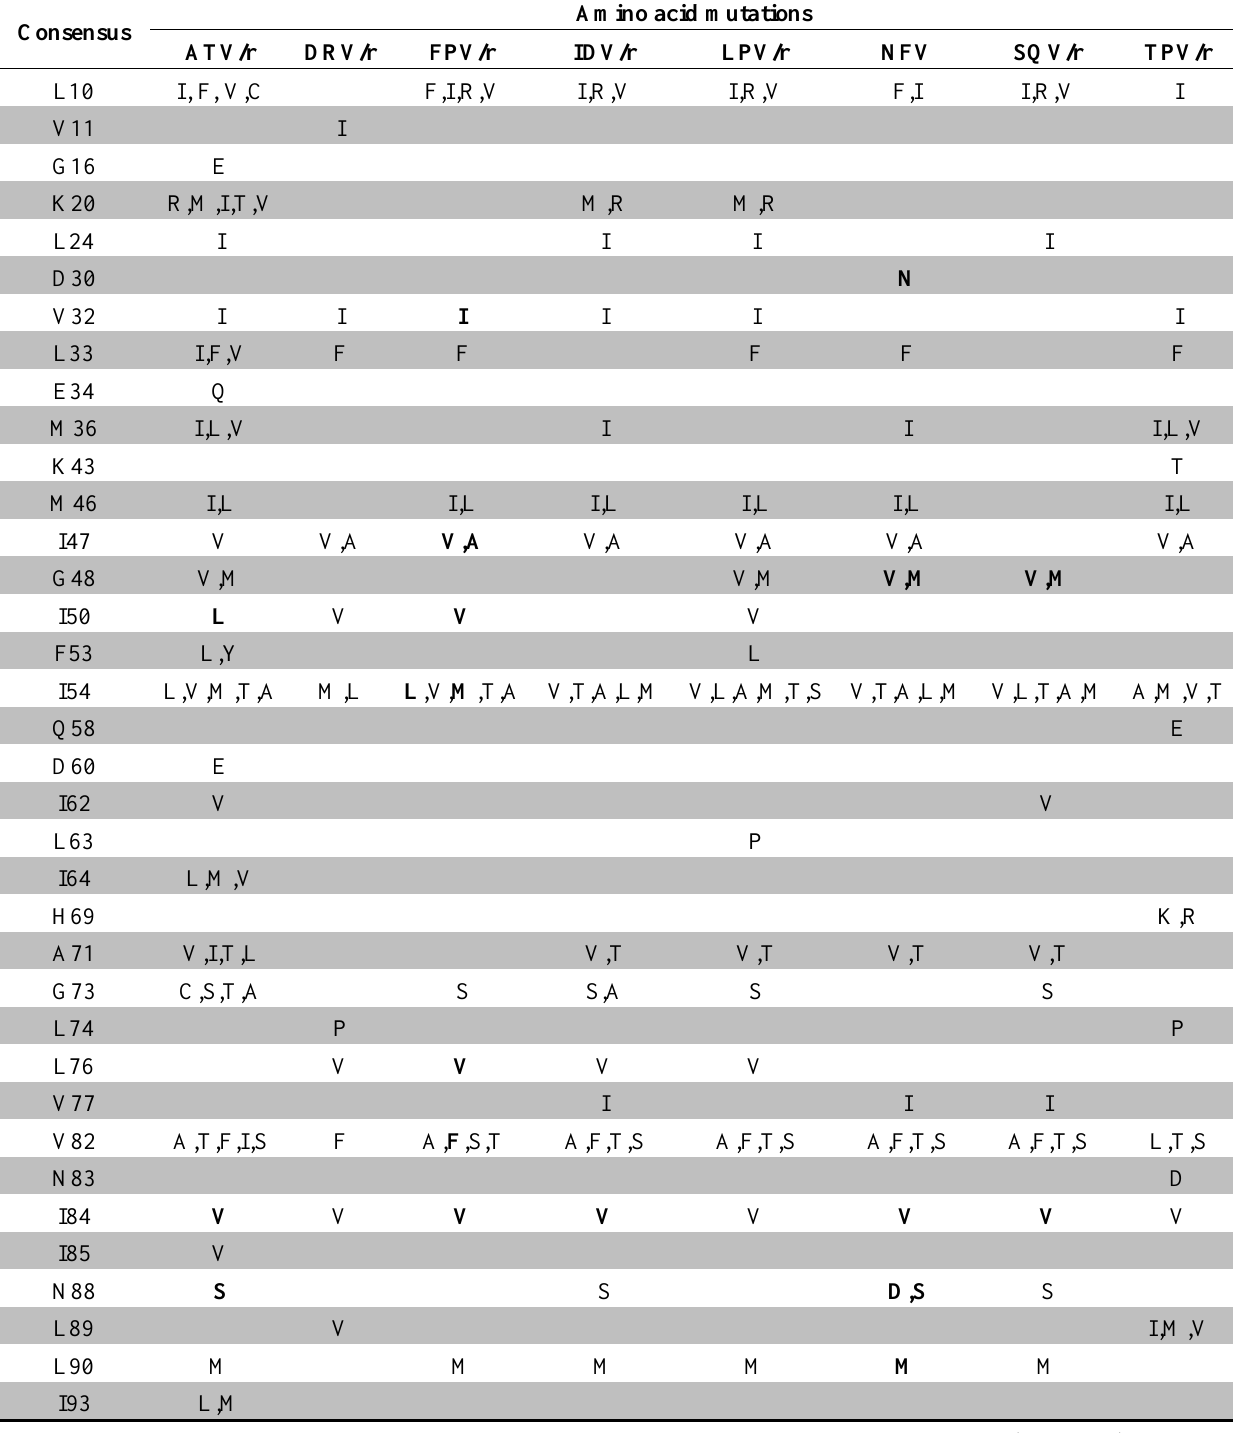
Table 4. Major Protease Inhibitor Resistance